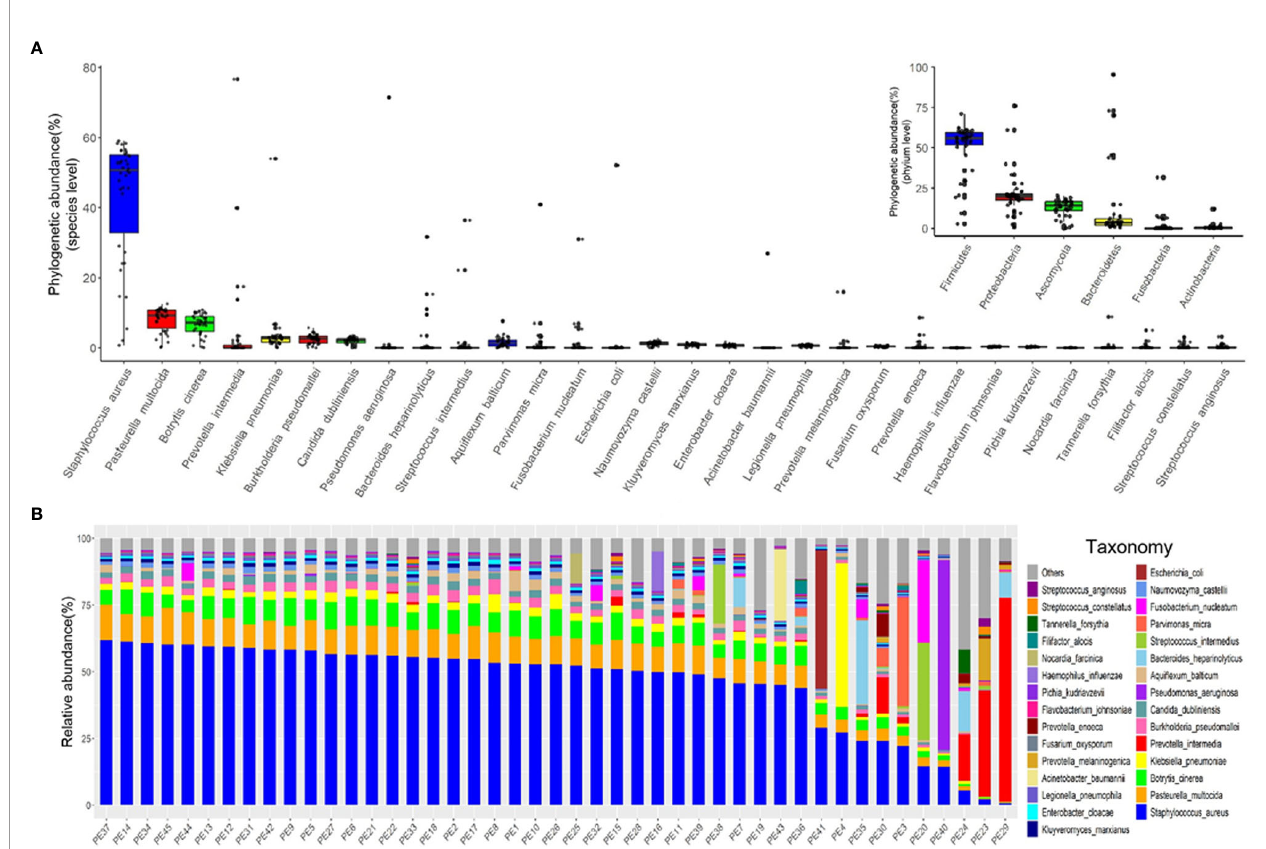
FIGURE 1 | The major microbiome taxa at the phylum and species levels in the pleural effusion samples. (A) Box plot of species abundance variation for the 30 most abundant species as determined by read abundance. Species are colored by their respective phylum (see inset for color key). Inset displays the box plot of abundances at the phylum level. (B) Stacked bar plot of the 30 most abundant species in the pleural effusion microbiome.